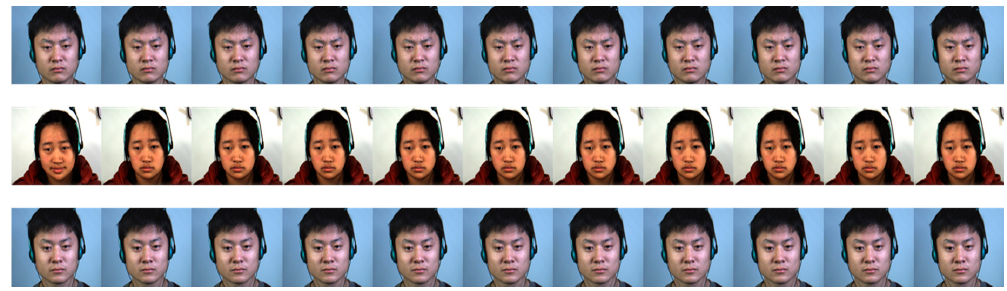
Figure 10. Example of the 11 frames used to recognize the type of the ME. First row: an example of a